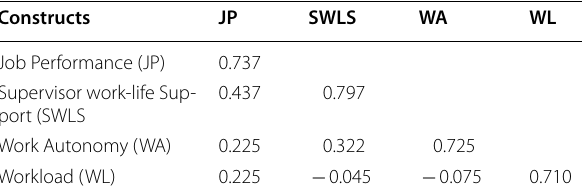
Table 2 Fornell-Larcker criterion